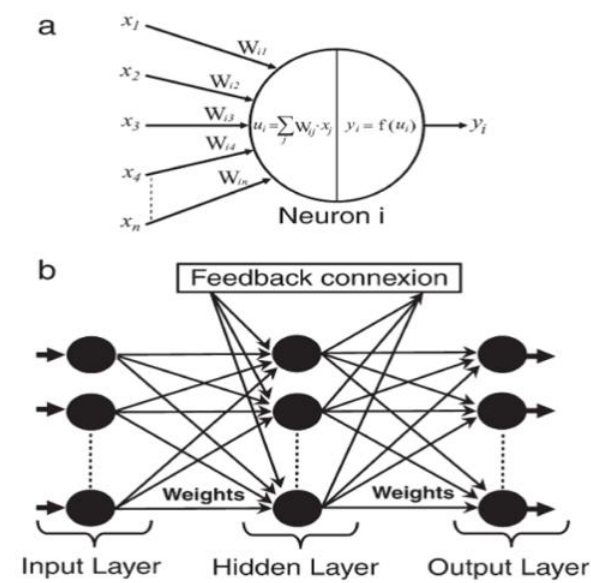
Fig. 2. General topology of a feed-forward ANN with one hidden layer (b)